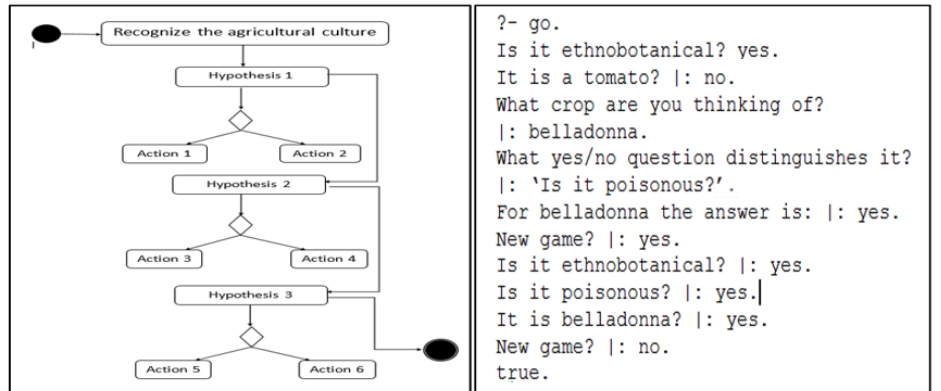
Figure 15. Game control scheme by the Gamer and its implementation.